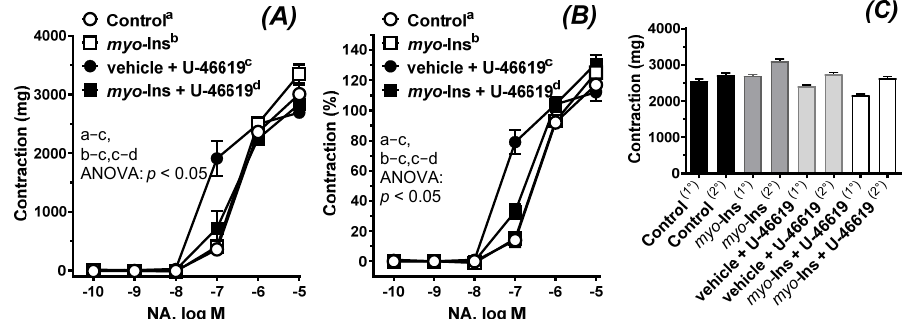
Figure 3. The cumulative concentration-response curves to noradrenaline ( A , B ) and 75 mM KCl ( C ) in the isolated thoracic arteries of the control (a), myo -inositol alone (b), vehicle plus U-46619 (c), myo -inositol plus U-46619 (d). Aortic rings were pre-incubated with either myo -inositol (1 μ M, 60 min)—groups b and d or vehicle (KHS)—groups a and c. Next, aortic rings were subjected to U- 46619 (0.1 nM, 60 min)—groups c and d. Contraction to KCl was performed before and after the 2-